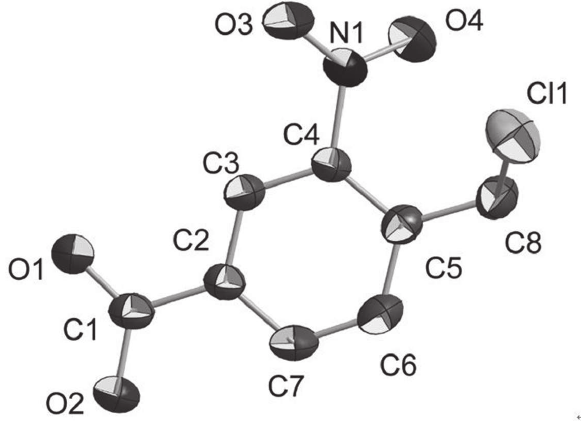
Table 2: Fractional atomic coordinates and isotropic or equivalent isotropic displacement parameters (Å 2